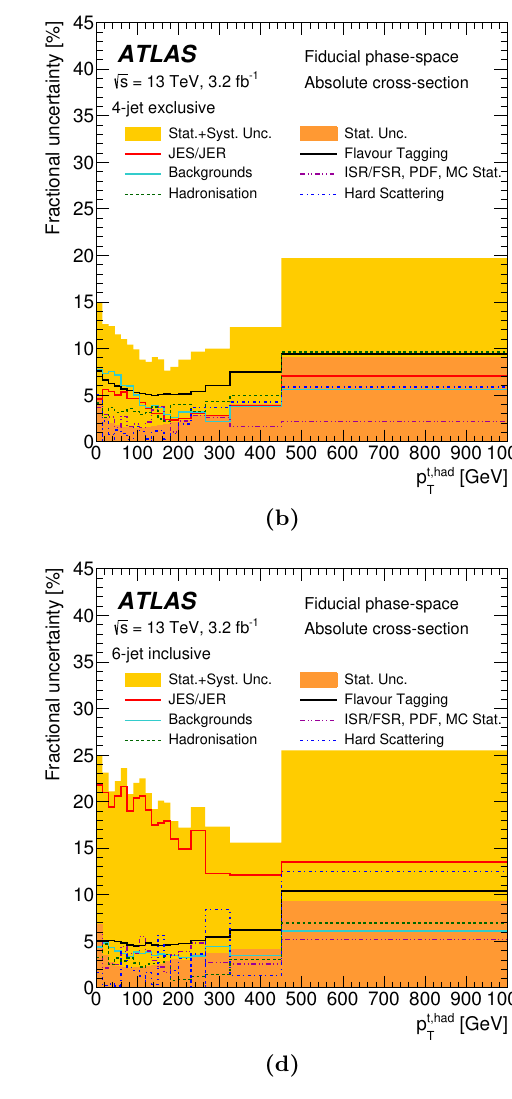
Figure 7 . Uncertainties in the (cid:12)ducial phase space di(cid:11)erential cross sections as a function of p t; had : normalised (a) in the 4-jet exclusive con(cid:12)guration; absolute (b) in the 4-jet exclusive, (c) 5- T jet exclusive, and (d) 6-jet inclusive con(cid:12)gurations. The yellow bands indicate the total uncertainty in each